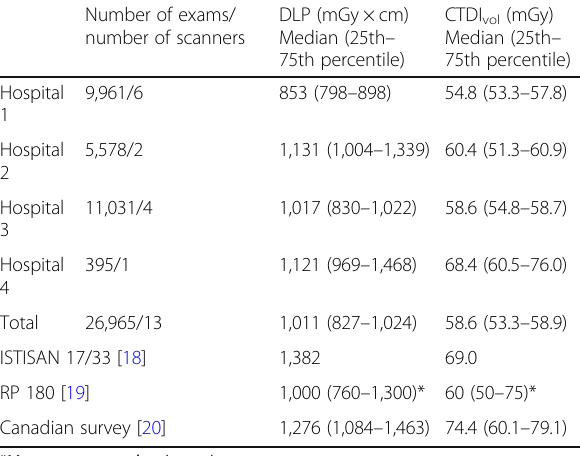
Table 1 Dose-length product (DLP) and volumetric computed tomography dose index (CTDI vol ) for the study common name “ CT Head WO ” : data from individual hospitals, total